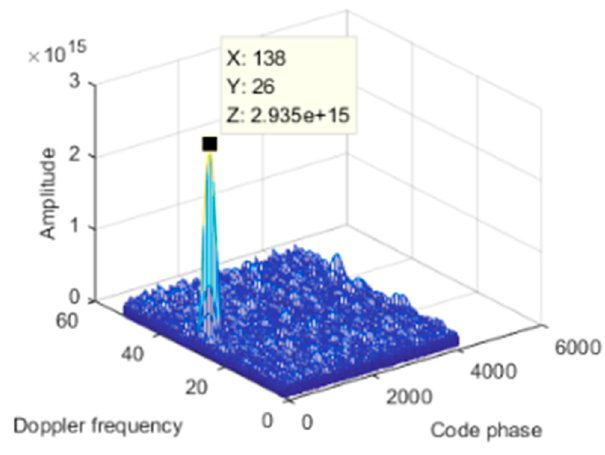
Figure 12. Acquisition Figure 12 . Acquisition result. Figure 12 . Acquisition result.